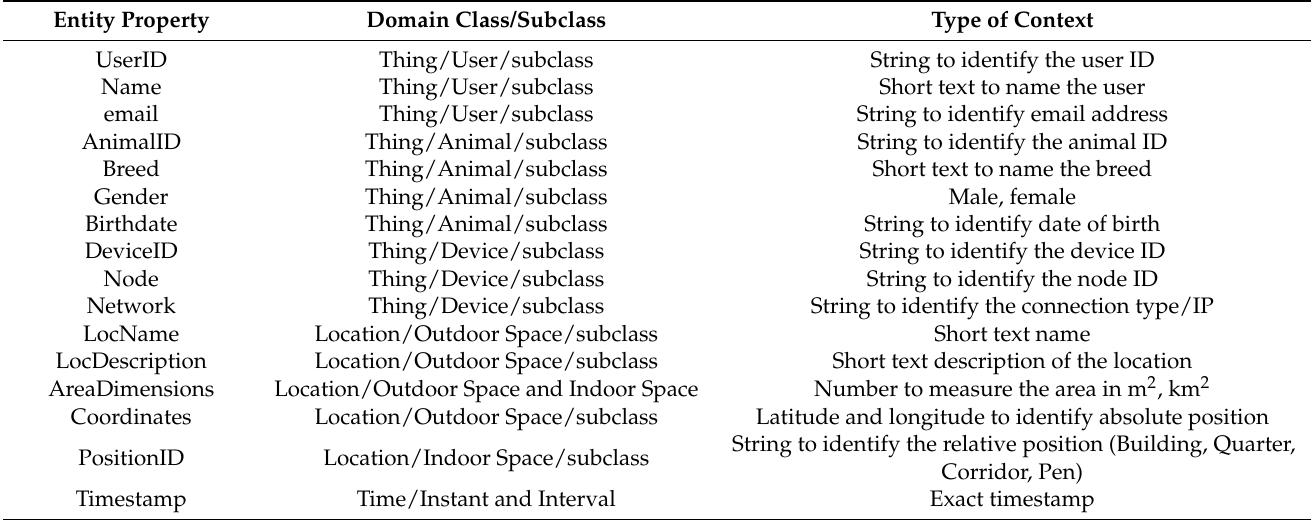
Table 3. Indicative properties of ontology